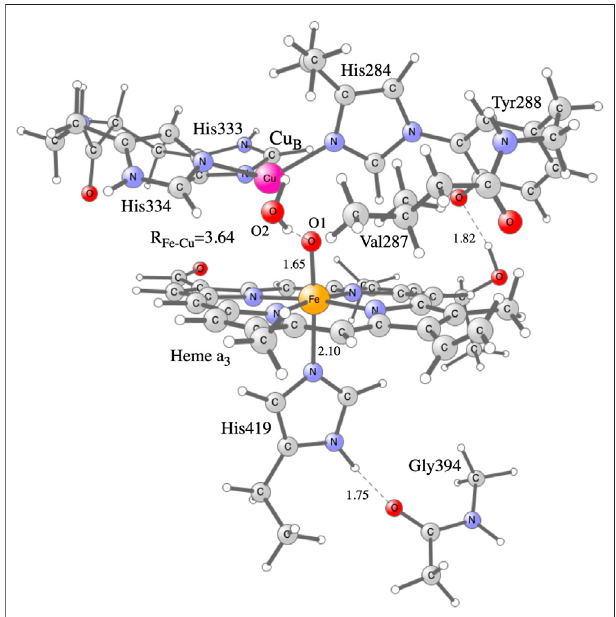
FIGURE 2 | Model of the active site in C c O used in the present calculations, showing the optimized F state.